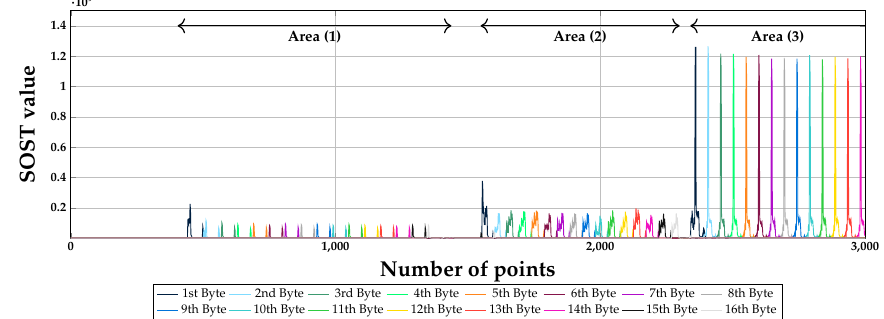
Figure 3. SOST results for block cipher AES with no countermeasure when the plaintext is stored. Guessing entropy